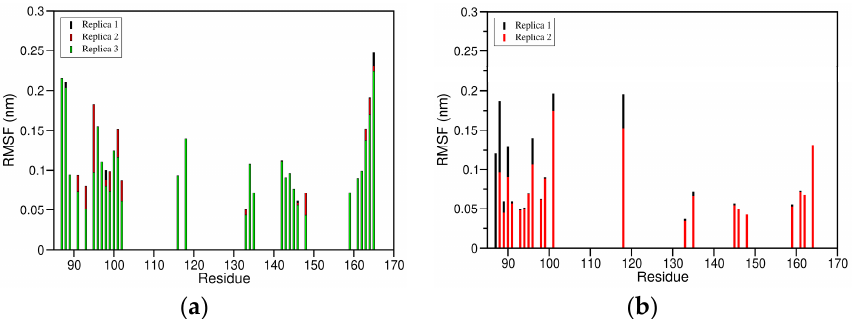
Figure 10. RMSF of NS1 interfacial residues. ( a ) RMSF of the NS1 interfacial residues with PI3K; ( b ) RMSF of the NS1 interfacial residues with TRIM25.